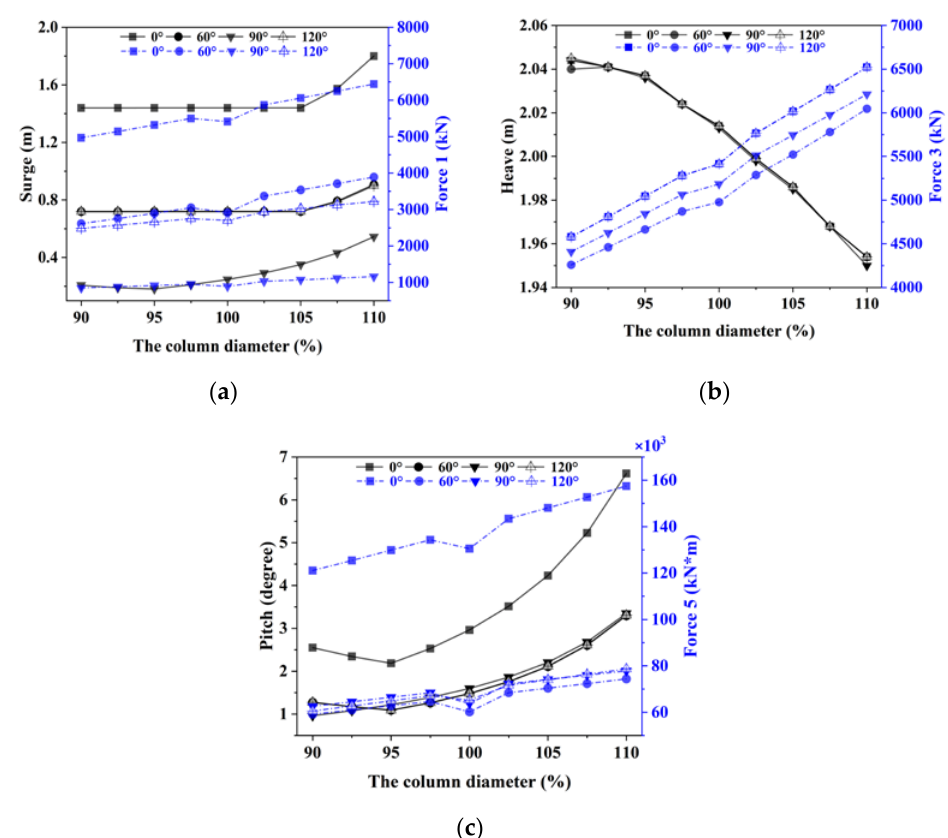
Figure 11. The peak values of the transfer functions with different column diameters in the different wave directions: ( a ) Peak values of surge motion and Force 1 transfer functions; ( b ) peak values of heave motion and Force 3 transfer functions; ( c ) peak values of pitch motion and Force 5 transfer functions.